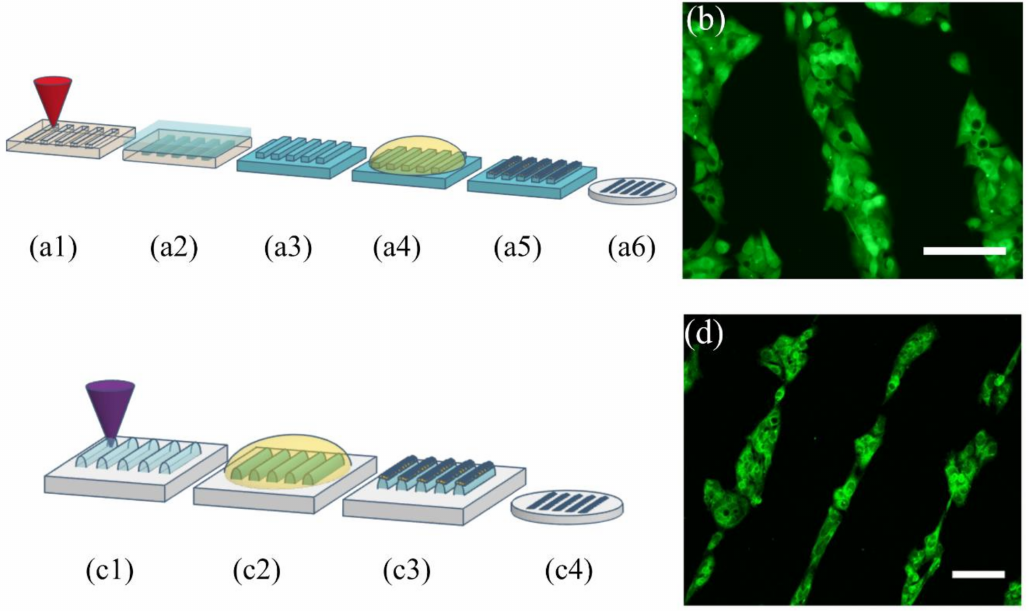
Figure 8. Diagram of PMMA laser etching for the fabrication of µ CP master molds: ( a1 ) Laser etching of PMMA to obtain a mastermold, ( a2 ) PDMS is poured onto the PMMA structured master, ( a3 ) the stamp is peeled off the master, ( a4 ) the stamp is incubated with an ink solution, ( a5 ) the excess of solution is removed, ( a6 ) the inked stamp is placed onto a glass coverslip and the protein pattern is suitable for cell culture. ( b ) HepG2 cells grow selectively onto the collagen I protein pattern (green is calcein (live cells), scale bar: 100 µ m. Diagram of Loctite DLW for the fabrication of µ CP stamps in one single step: ( c1 ) Selective laser crosslinking of Loctite to obtain the desired stamp, ( c2 ) the stamp is incubated with an ink solution, ( c3 ) the excess of the solution is removed, ( c4 ) the inked stamp is placed onto a glass coverslip and the protein pattern is suitable for cell culture. ( d ) HepG2 cells onto the transferred protein pattern (green is phalloidin as actin cytoskeleton marker), scale bar: 100 µ m.